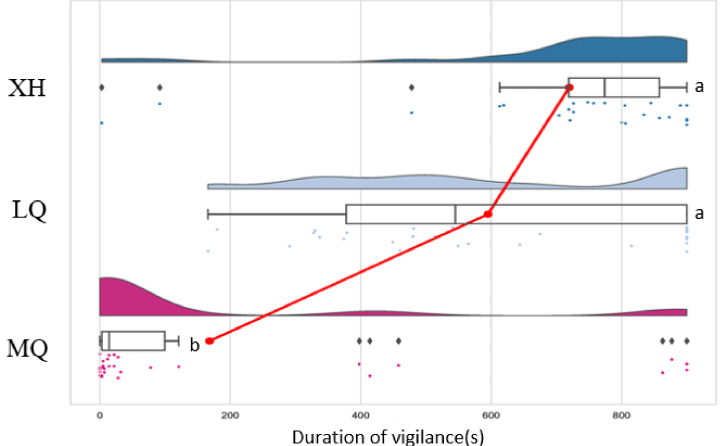
Figure 8. Alert duration of plateau pikas in different areas during playback experiments. Note: XH stands for Xiahe county (altitude: 3212 m), LQ stands for Luqu county (altitude: 3383 m) and MQ stands for Maqu county (altitude: 3587 m). The graph is composed of four parts, from top to bottom: a half violin plot representing the data core density; a boxplot representing the average level and fluctuation degree of the sample data; data points providing the dispersion of the sample data; and a line connecting the mean values of different groups. By comparing the warning duration at XH, LQ and MQ, it was found that their averages were 721.817 s, 594.929 s and 168.258 s, respectively. Note: Firstly, arrange all averages in descending order, and then label the letter a on the largest average; and compare the average with the following averages. If there is no significant difference, label it with the letter a until a significant difference is found, and label it with the letter b. Further statistical testing ( p < 0.05) showed that there was a significant difference between the warning durations at the three locations and that the warning duration at XH and LQ was significantly higher than that at